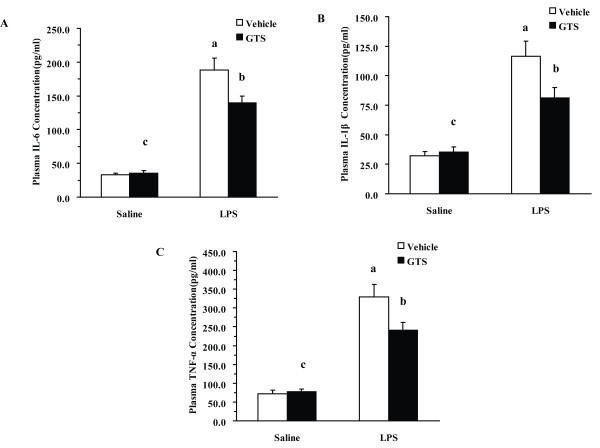
Effects of GTS on plasma proinflammatory cytokines levels in different groups post LPS or saline challenge. Mice were treated as in Figure 1. Plasma was collected 4 h after saline or LPS challenge. Cytokines were determined using commercial ELISA kits. The plasma concentrations of IL-1β, IL-6, and TNF-α 4 h post LPS or saline challenge are represented in Figures 4A, 4B, and 4C (n = 8 mice for each group). The data are expressed as mean ± SEM. For statistical significance, a: p < 0.01 compared with the vehicle/saline group, b: p < 0.05 compared with the vehicle/LPS group. c: p < 0.01 or p < 0.05 compared with the LPS/GTS group.